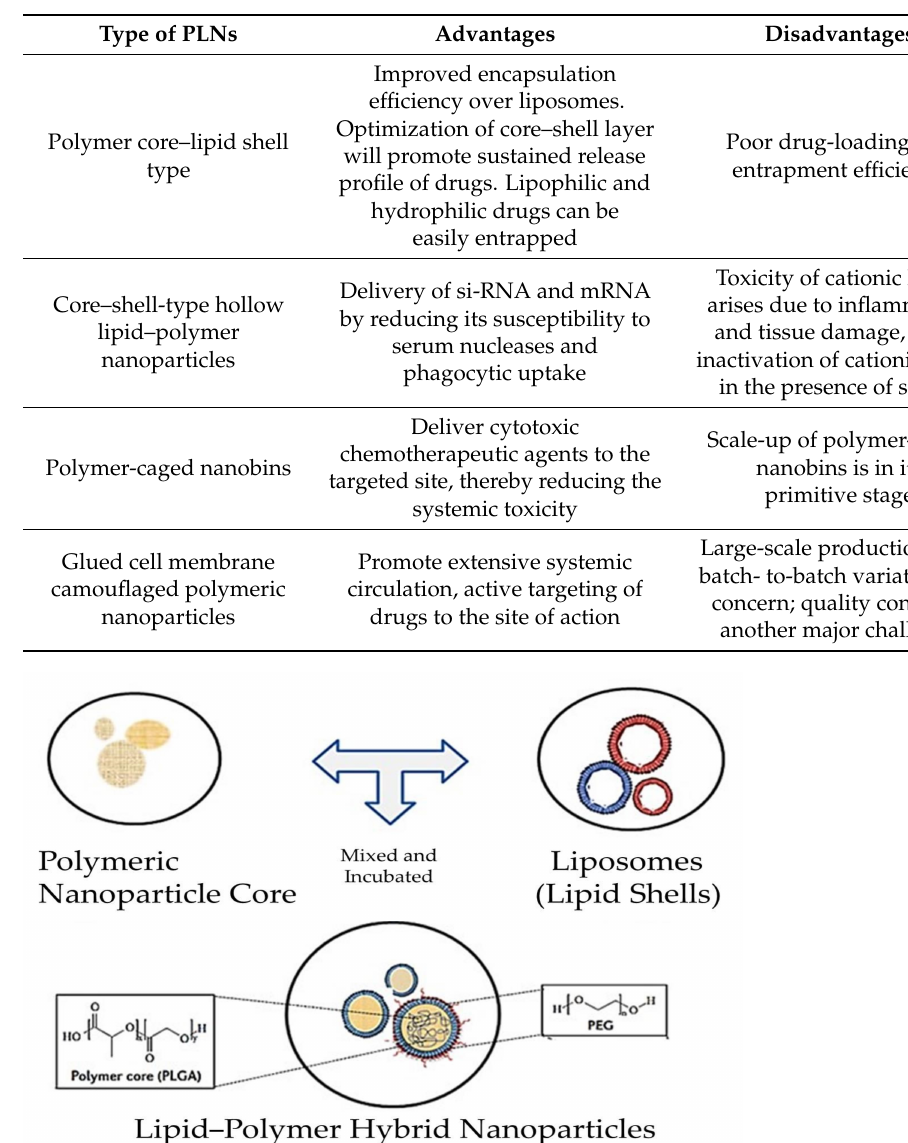
Table 1. Comparison of polymeric lipid hybrid nanoparticles [46].